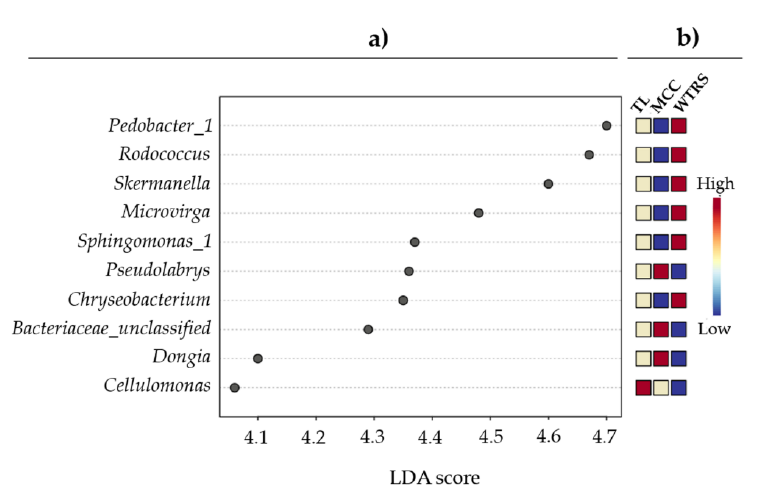
Figure 2. ( a ) Linear discriminant analysis (LDA) scores and, ( b ) heatmap from blue (low) via white to red (high) of genus relative abundances in root-associated soil of wild tomato related species (WTRS), tomato landraces (TL), and modern commercial cultivars Table 1. Richness estimates and diversity indices (means ± SE) for 16S rRNA libraries of tomato rhizosphere soils. Different letters indicate a significant difference among tomato varieties ( p < 0.05, ANOVA, Dunn’s post hoc-Bonferroni corrected p values) when exist. WTRS: wild tomato related species; TL: tomato landraces; MCC: modern commercial cultivars. WTRS TL